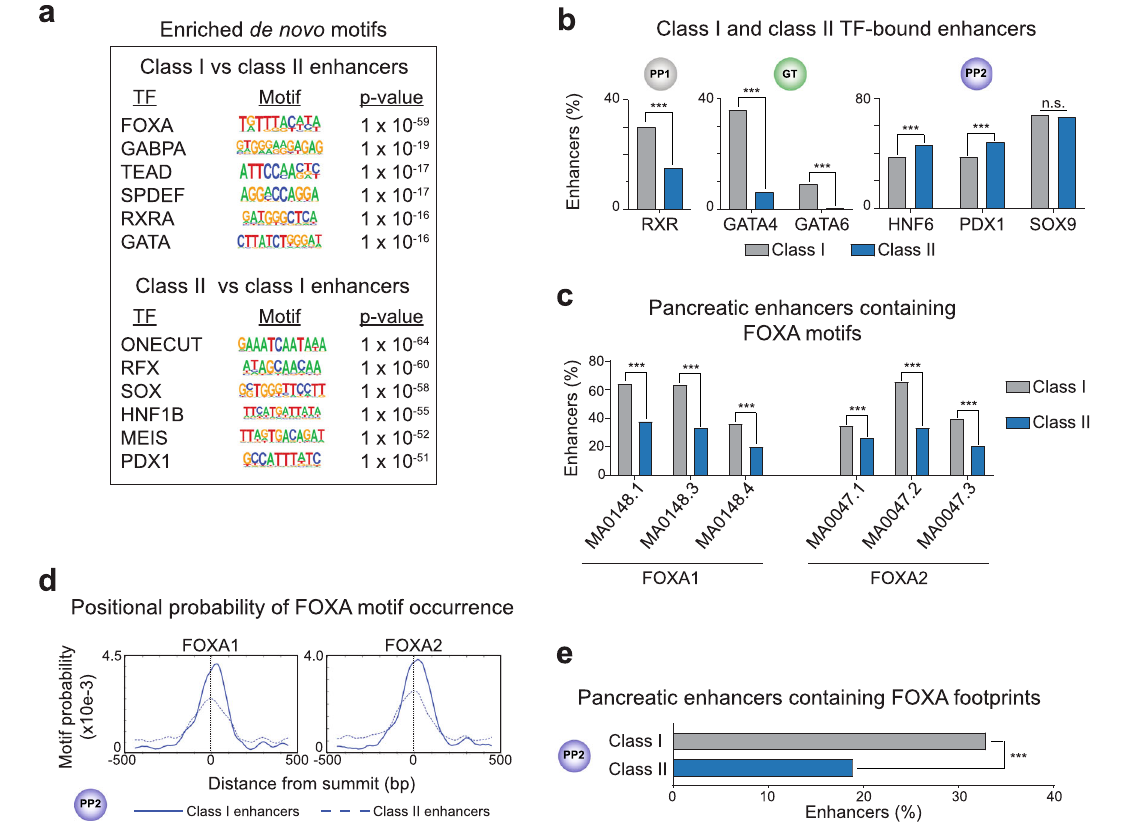
Fig. 4 FOXA1/2-binding sites at class I and class II pancreatic enhancers differ in DNA sequence. a Enriched de novo transcription factor (TF)-binding motifs at class I against a background of class II pancreatic enhancers and vice versa. Fisher ’ s exact test, 1-sided, corrected for multiple comparisons. b Percentage of class I and class II enhancers overlapping RXR ChIP-seq peaks in PP1; GATA4 and GATA6 ChIP-seq peaks in GT; and HNF6, PDX1, and SOX9 ChIP-seq peaks (within 100 bp from peak) in PP2 ( P = 8.27 × 10 − 14 , <2.2 × 10 − 16 , <2.2 × 10 − 16 , 3.52 × 10 − 4 , 1.01 × 10 − 5 , and 0.40 for comparisons of overlap with binding sites for RXR, GATA4, GATA6, HNF6, PDX1, and SOX9, respectively; Fisher ’ s exact test, 2-sided). c Percentage of class I and class II enhancers with at least one occurrence of selected FOXA1 and FOXA2 motifs ( P = < 2.2 × 10 − 16 , <2.2 × 10 − 16 , 1.76 × 10 − 13 , 1.61 × 10 − 4 , <2.2 × 10 − 16 , and <2.2 × 10 − 16 for comparisons of occurrences of MA0148.1, MA0148.3, MA0148.4, MA0047.1, MA0047.2, and MA0047.3, respectively. Fisher ’ s exact test, 2-sided). d Probability (motif occurrence per base pair) of FOXA1 (MA0148.3) and FOXA2 (MA0047.2) motifs relative to ATAC-seq peak summits at class I (solid line) and class II (dashed line) enhancers. ATAC-seq peak summits at class I enhancers are enriched for occurrences of